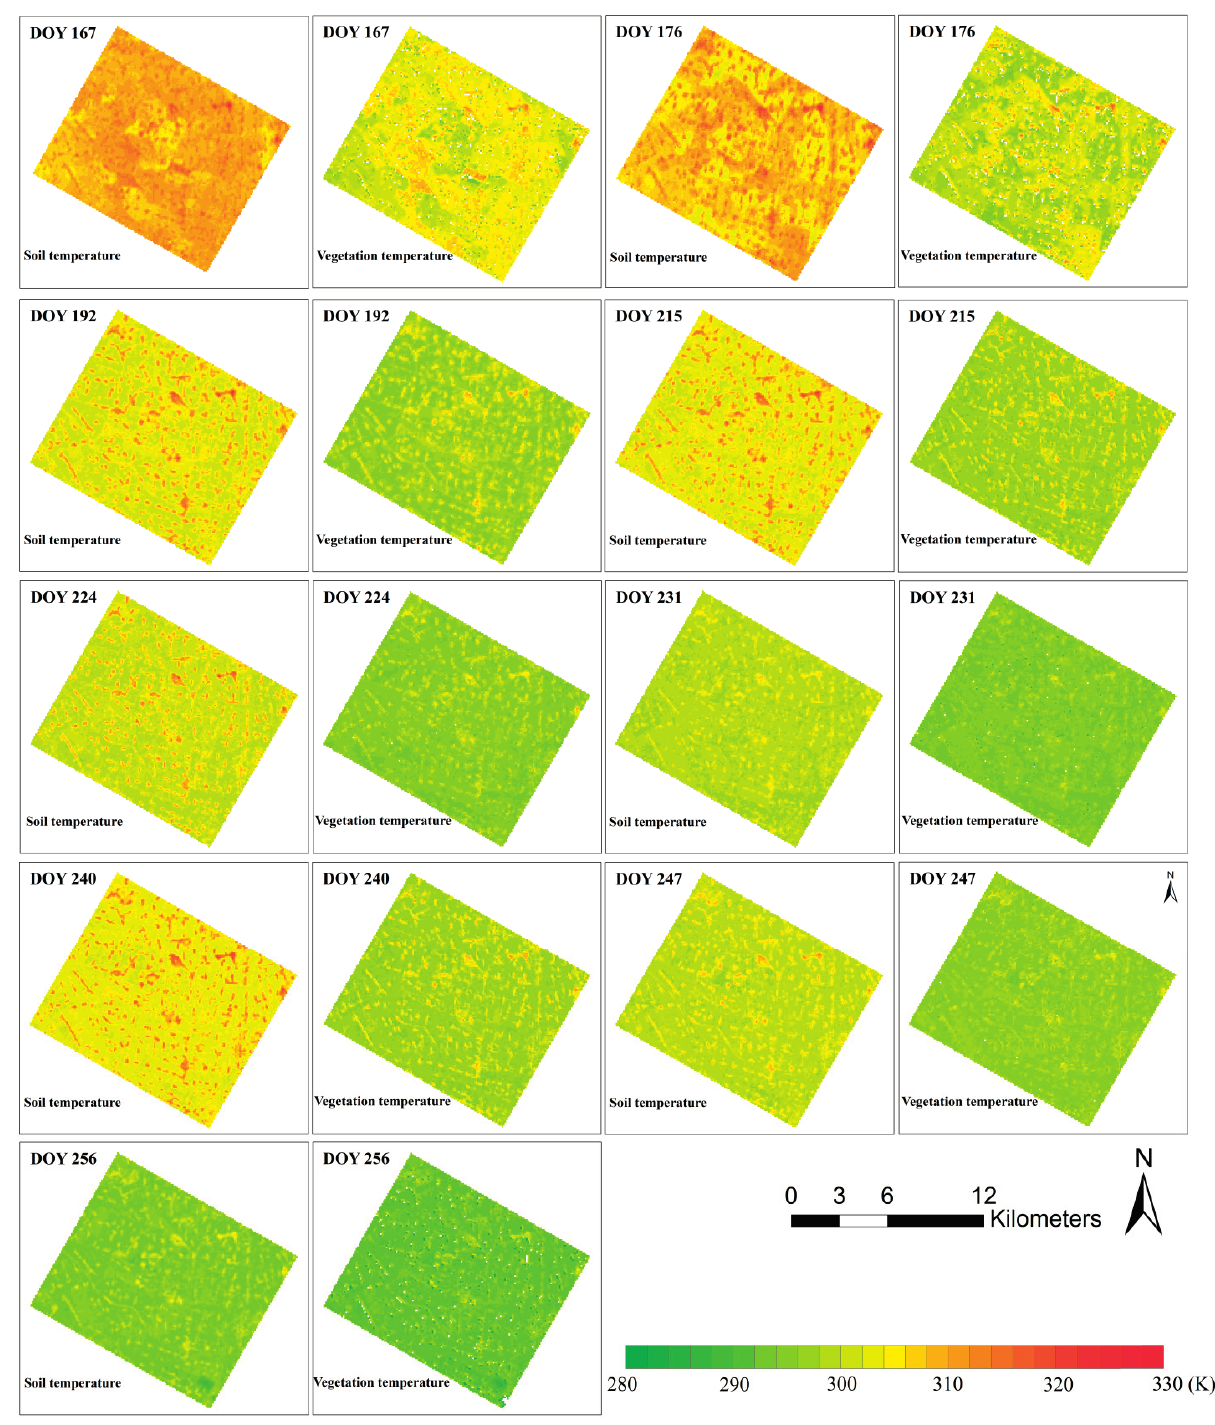
Figure 5. The spatial distribution of soil and vegetation component temperatures from nine ASTER images during the growing